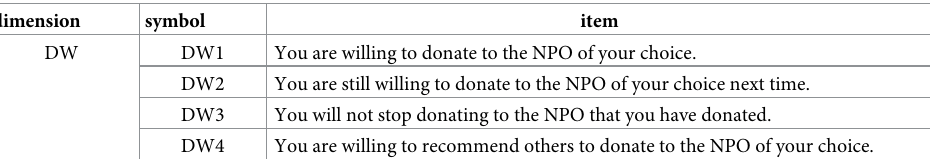
Table 6. Individual donation intention